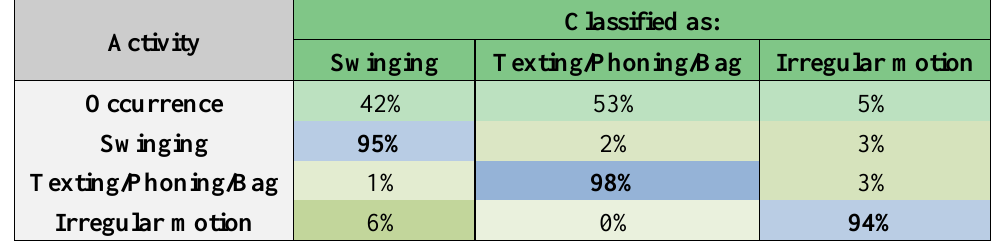
Table 1. Confusion matrix for the motion mode classifier in the “ free motion‖ data